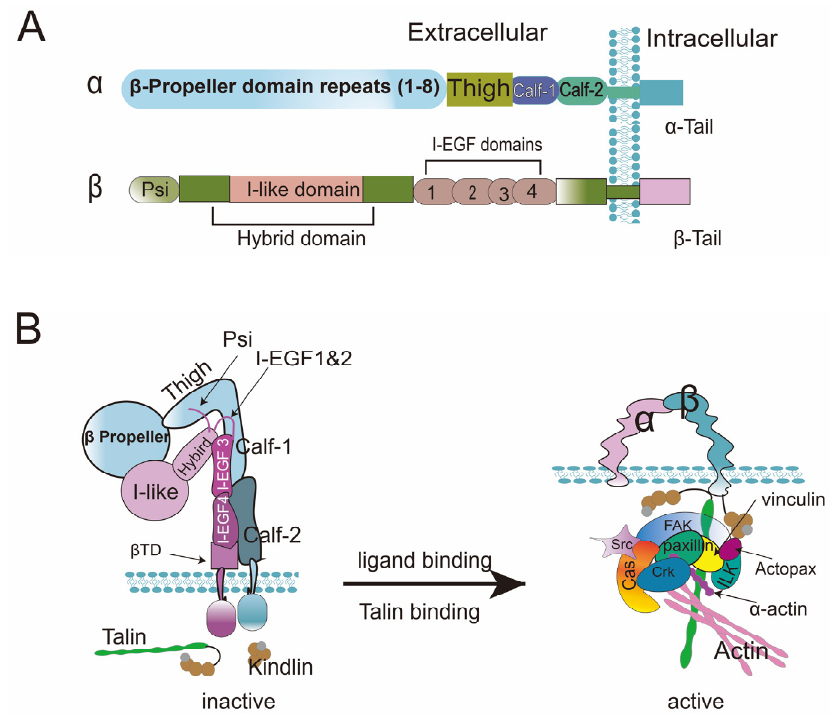
Figure 1. ( A ) Domain organization and structure of a generic integrin. α and β Subunits synthesize heterodimeric proteins that adhere to the cell surface. ( B ) Integrin activation. In the active state, the recruitment of talin and kindlin by the β subunit’s intracellular domain leads to the extension of the integrin leg and separation of dimeric subunits (at the transmembrane and cytoplasmic domain levels). Upon Talin and kindlin binding to β subunits, intracellular adaptor proteins and enzymes are clustered to form the focal adhesion complex (composed of Src, FAK, Crk, Cas, vinculin, ILK, paxillin, actopax, α -actin, and talin), which in turn strengthens the combination between integrins and ligands. (Cooper et al. [56] have reviewed this in 2019).